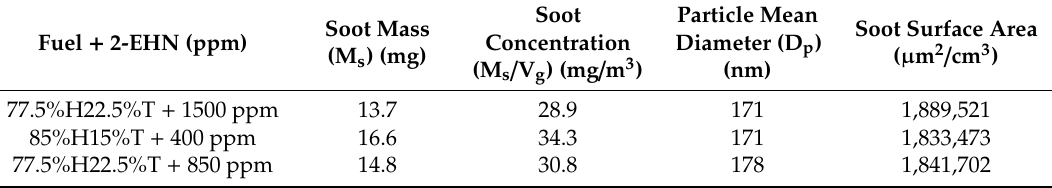
Table 6. Filter soot mass measurements with 2-EHN ignition